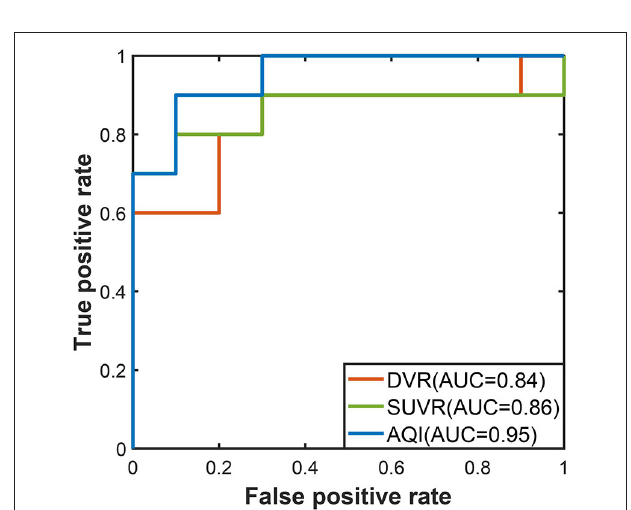
FIGURE 6 | ROC curves for three methods in the testing